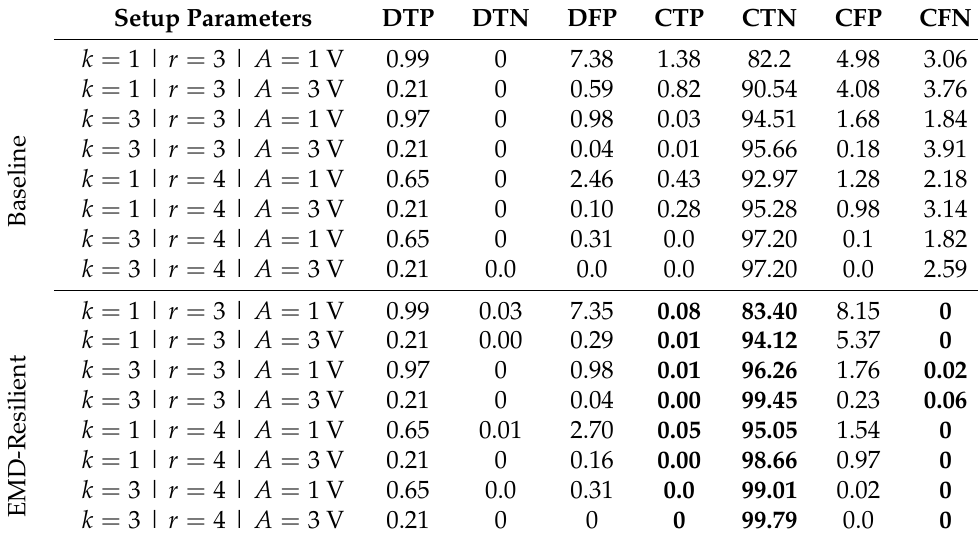
Figure 9. The impact of the inversion layer on the EM-resiliency of RSCodes for a symbol size of 3. Table 3. Performance comparison between the original RS Codes and the proposed version (in